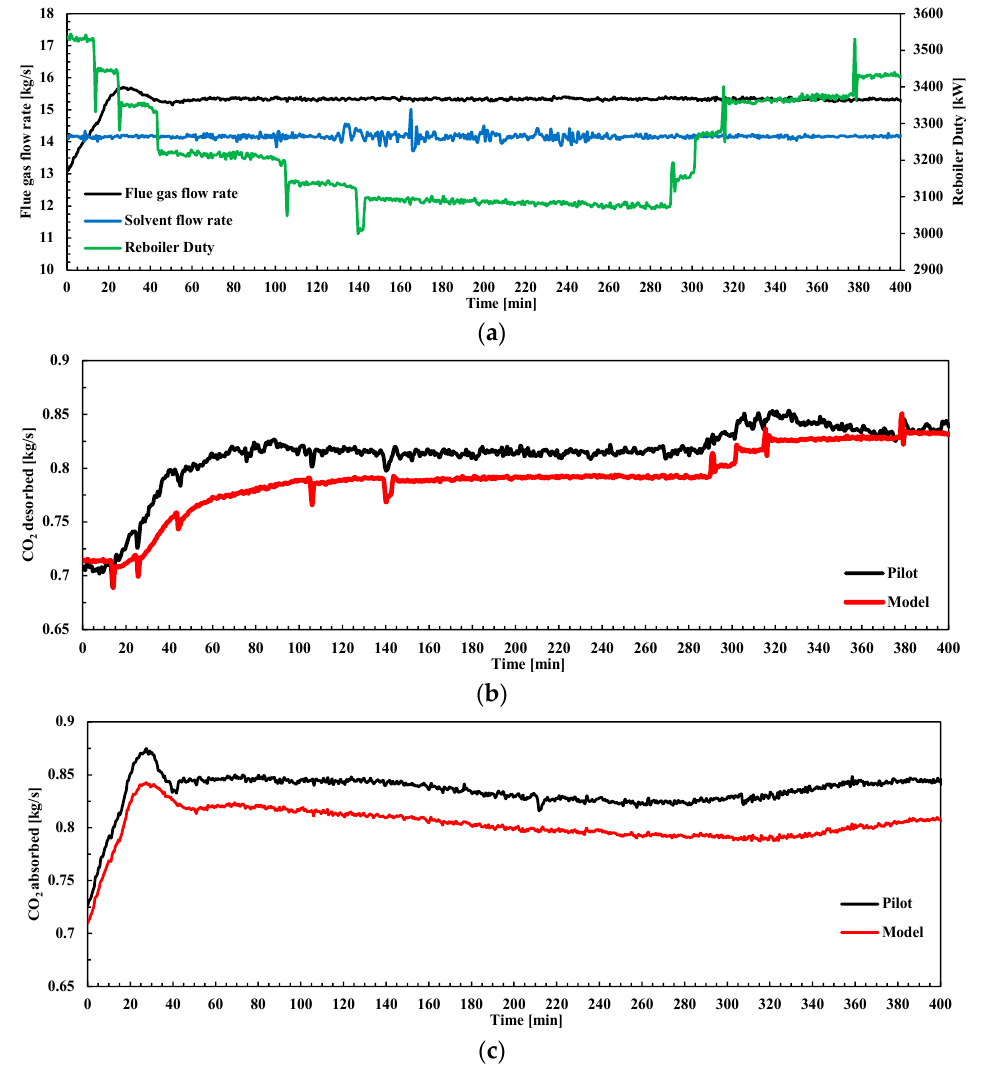
Figure 6. ( a ) Main inputs to the plant for test with flue gas flow rate set-point increase (kg/s). Rich solvent flow rate from absorber (kg/s) and reboiler duty (kW); ( b ) Pilot plant transient response and model output trajectory for CO 2 product flow rate F prod or CO 2 desorbed (refer to FT3 in Figure 1); ( c ) Pilot plant transient response and model output trajectory for CO 2 absorbed in absorber column, refer to Equation (11). The time t = 0 corresponds to the point from which the set point of flue gas volumetric flow rate was